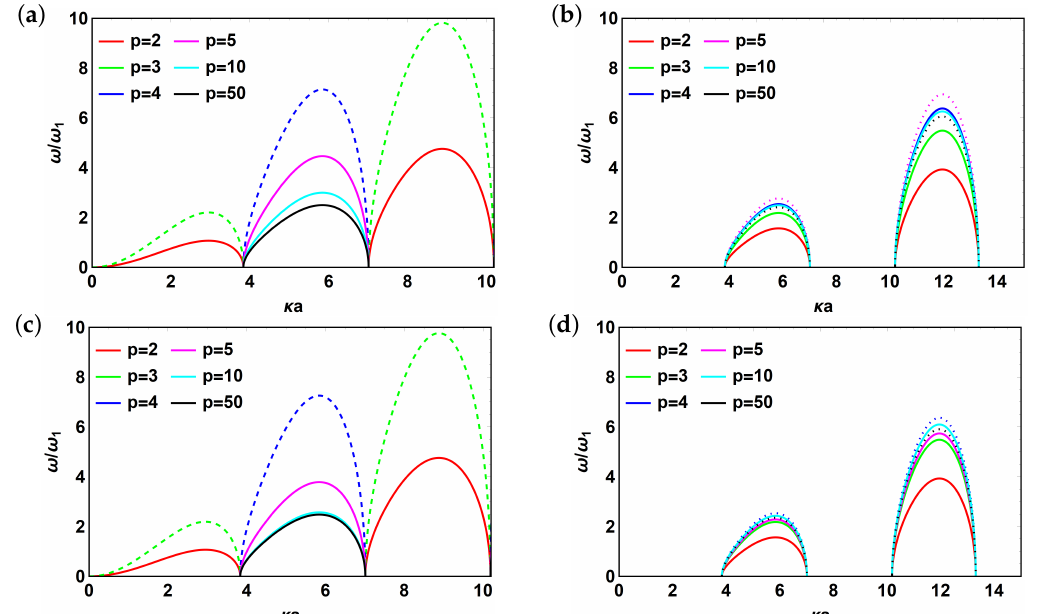
Figure 4. Dispersion relation for metascreen ( a ) w/o interface and w/o reflector; ( b ) w/2 interfaces and w/o reflector, kh (cid:28) 1, δ (cid:28) 1; ( c ) w/2 interfaces and w/o reflector, kh (cid:28) 1, “negative” branch; ( d ) w/2 interfaces and w/o reflector, kh (cid:28) 1, “positive” branch. For all plots n = 1, q = 2. Dashed lines in ( a , c ) are used to demonstrate switching between modes; dotted lines in ( b , d ) demonstrate the largest resonant peak for various configurations of metamaterial and compare it with the case of independent scatterers (black curve).